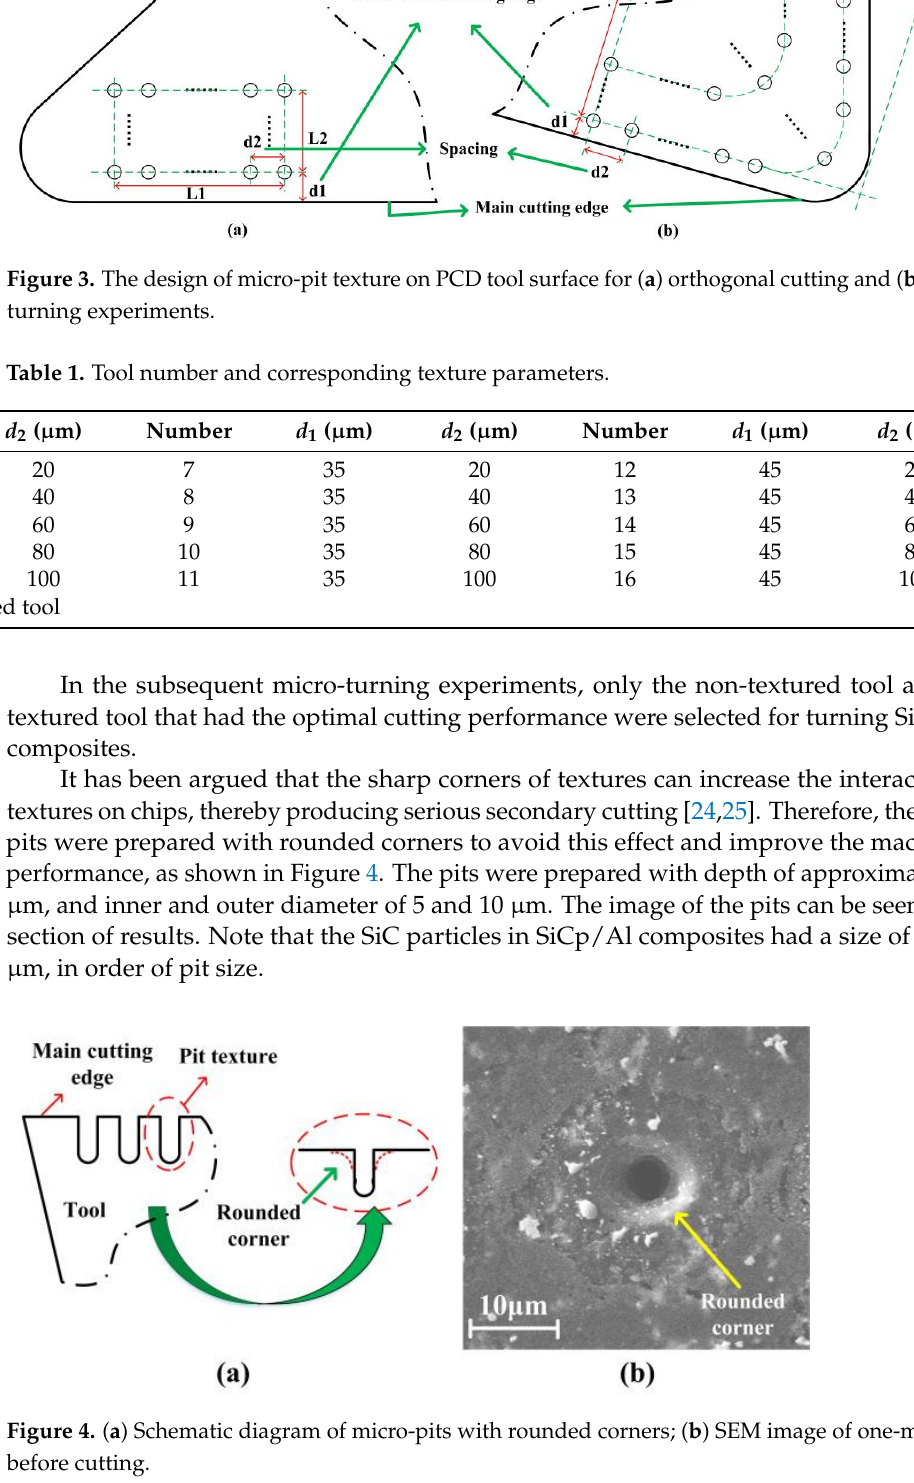
Figure 4. ( a ) Schematic diagram of micro-pits with rounded corners; ( b ) SEM image of one-micro pit before cutting.